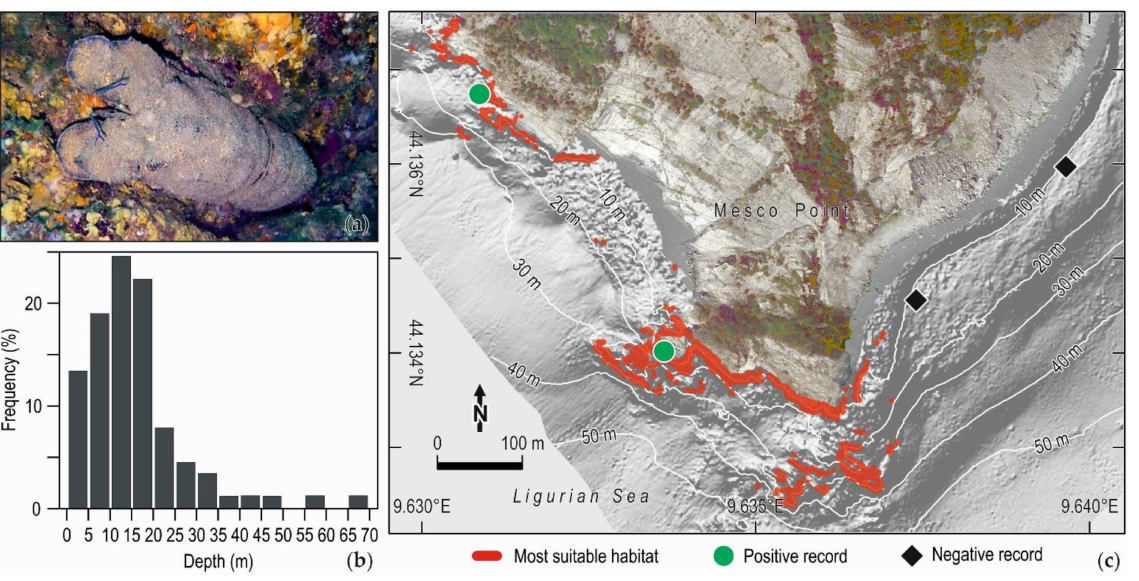
Figure 3. Suitability modelling to locate a species of conservation interest in a marine protected area: ( a ) the slipper lobster Scyllarides latus ; ( b ) its preferred depth according to literature information; ( c ) habitat suitability model superimposed to the seafloor map (obtained by merging aerial photog- raphy and multibeam survey) of Mesco Point, in the Cinque Terre MPA (NW Italy, Ligurian Sea), together with sea truth results by scuba diving (based on information in